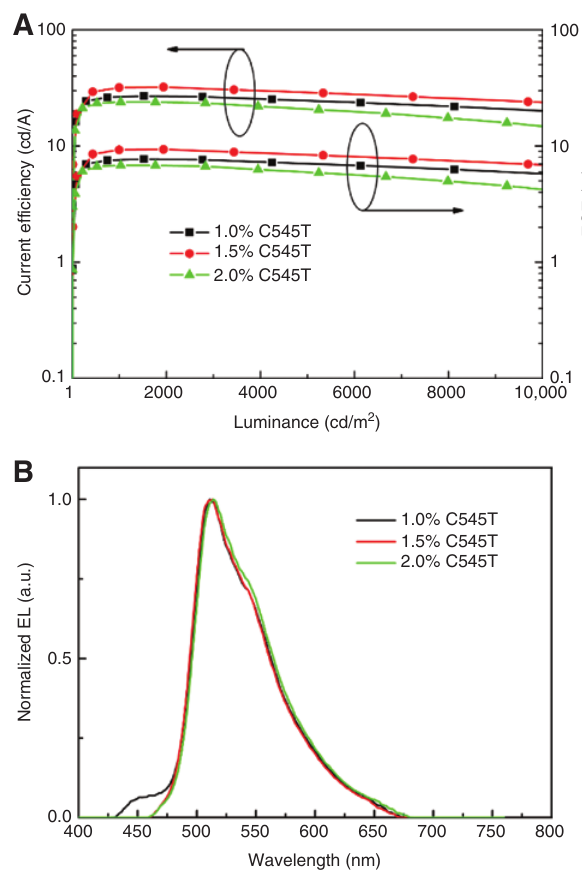
Figure 1: The EL performance of Fl-OLEDs with different C545T concentrations. (A) The current efficiency-luminance-EQE curves. (B) The EL